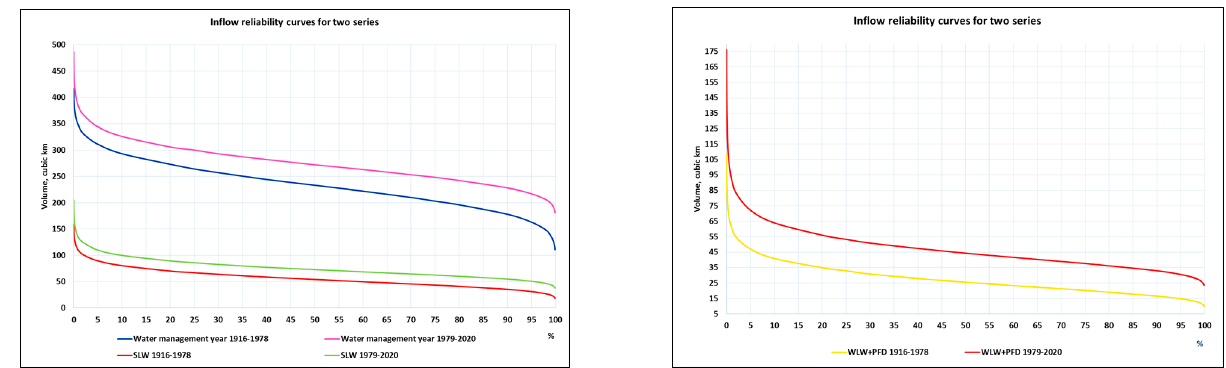
Figure 9. Reliability graphs of inflow reliability for two long-time series and different seasons. Table 9. Comparison of inflow volumes for two long-time series, different runoff reliability years, and different seasons.